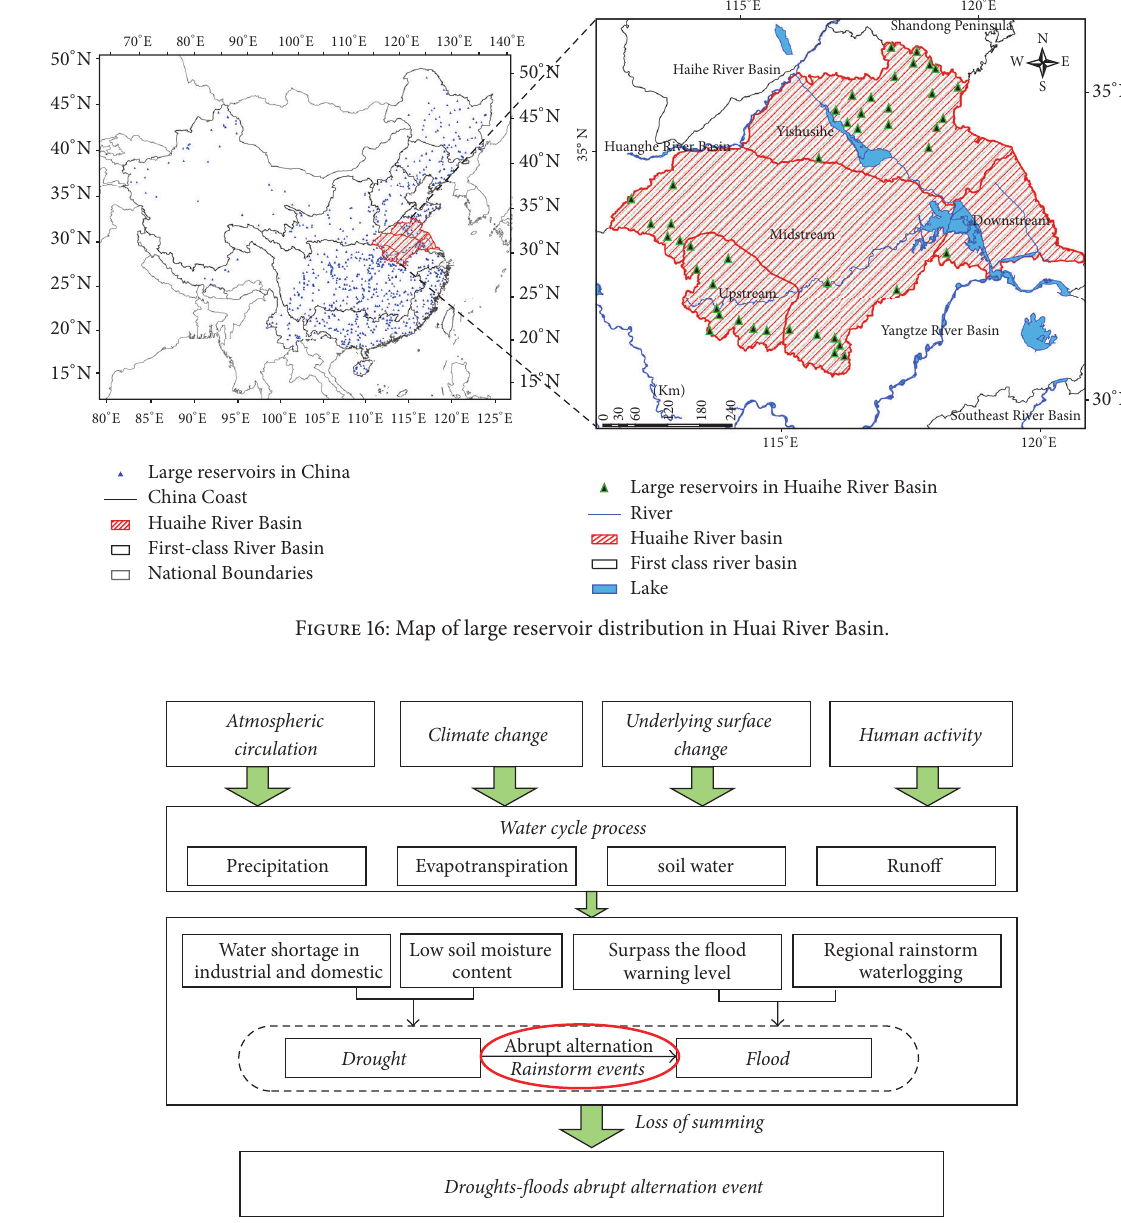
Figure 17: Formation mechanisms of drought-flood abrupt